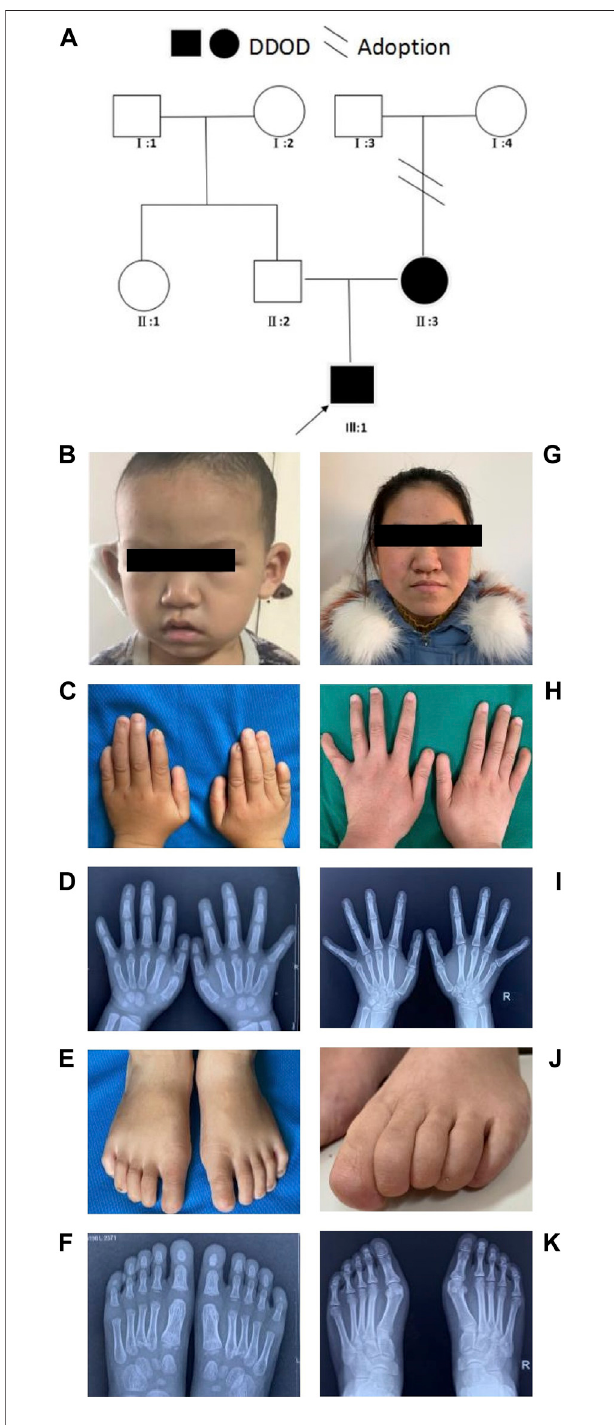
FIGURE 1 | Clinical fi ndings of family 1. (A) Family tree. (B – F) Proband and onychodystrophy. In fi ngers (C,D) , absence of fi rst- and fi fth-digits fi ngernails,index fi ngersaplasia, fi nger-likethumbs,andshorter fi fth fi ngers.In toes (E,F) , absent toenailson the fi rst and second digits, and hypoplasia toenails on the third to fi fth digits of right foot; Left foot, absent toenails on the digits 1 – 3, rudimentary digits 4 – 5. Hand X-ray: distal phalanges absence of the index fi nger; hypoplasia of the distal phalanx of feet ’ s fi fth digits. (G – K) Phenotypes of onychodystrophy of the mother are similar to the